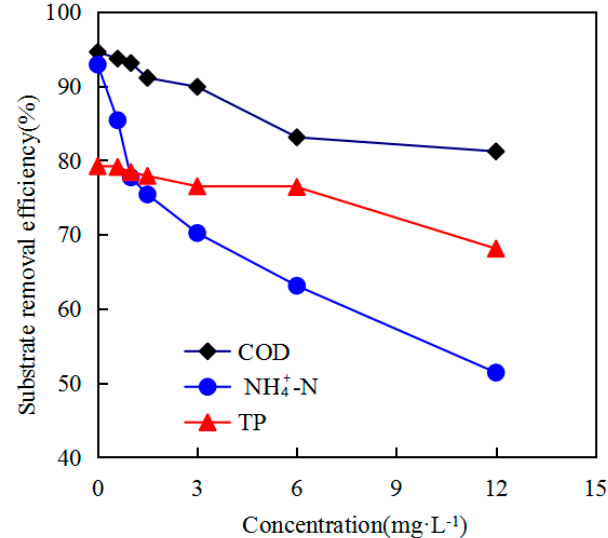
Figure 2. Impacts of metabolic uncouplers on COD elimination, NH 4 + -N, and TP elimination at different addition concentrations of TCS.